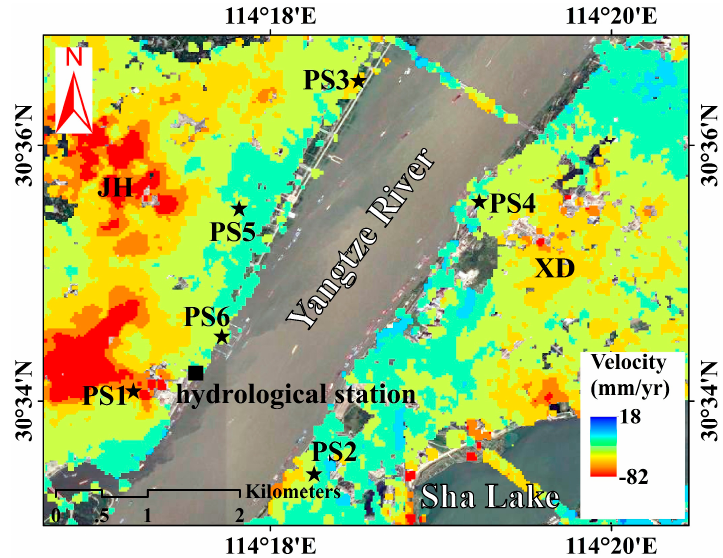
Figure 13. Surface vertical deformation rate map superimposed on Google Earth image covering both sides of the Yangtze River. The black square and five-pointed star denote the Hankou hydrological station and PS point, respectively. JH and XD are the abbreviations of Jianghan and Xudong, respectively.